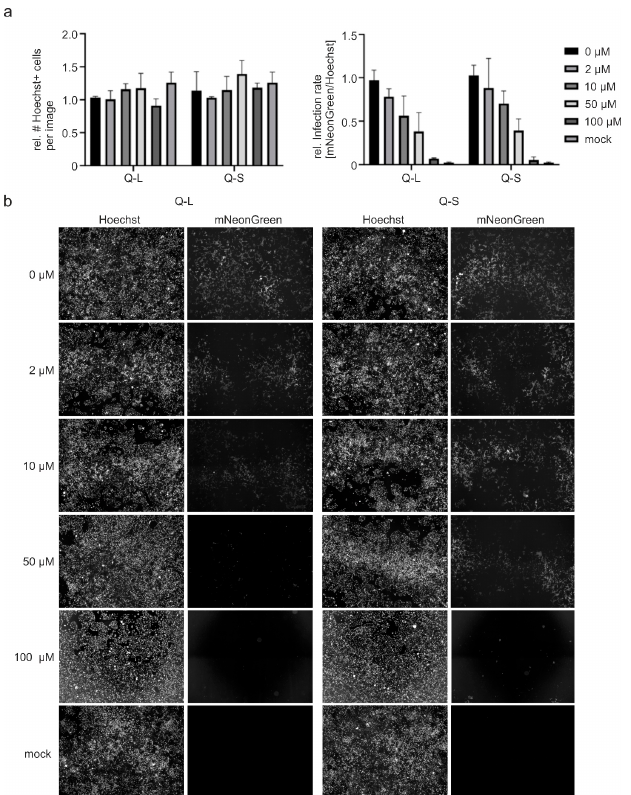
Figure 3. Influence of quinine on SARS-CoV-2-mNG infection in Caco-2 cells. Cells were infected with SARS-CoV-2-mNG at an MOI of 3 for 1 h or mock-infected. Then the inoculum was removed, and the cells were treated with the indicated amounts of Q-L or Q-S. At 48 h post-infection (hpi), cells were fixed with 2% PFA and nuclei were stained with 1 µg/mL Hoechst. The total amount of cells (Hoechst+) and infected cells (mNeonGreen+) were analyzed by automated microscopy. ( a ) Quantitative analyses of total cells and infected cells. Mean values and SD are calculated from two experiments with duplicate infections. ( b ) Representative fluorescence microscopy images taken at 4-fold magnification.